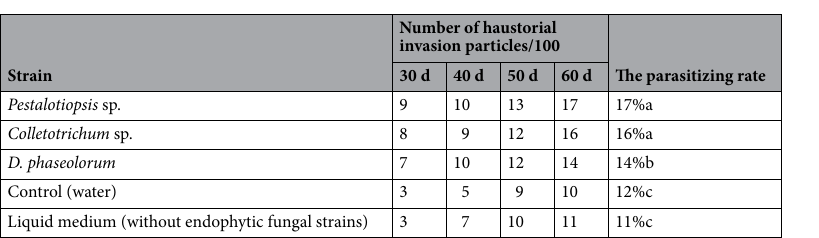
Number of haustorial invasion particles/100 The parasitizing rate30 d 40 d 50 d 60 d